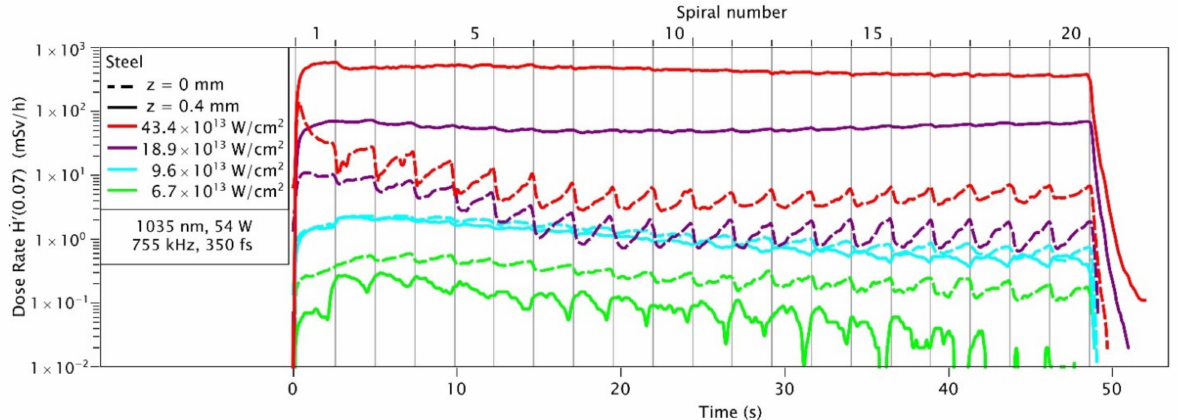
Figure 7. Dose rate ˙ H (cid:48) (0.07) recorded during different laser processing steps as function of the processing time. The OD-02 dosimeter was placed at a distance of 150 mm from the interaction zone. Each of the individual processing steps is marked by a number on the top of the graph and separated by vertical lines. The laser intensity is 4.2 × 10 14 W/cm 2 at a repetition rate 755 kHz and the focal spot diameter 22 µ